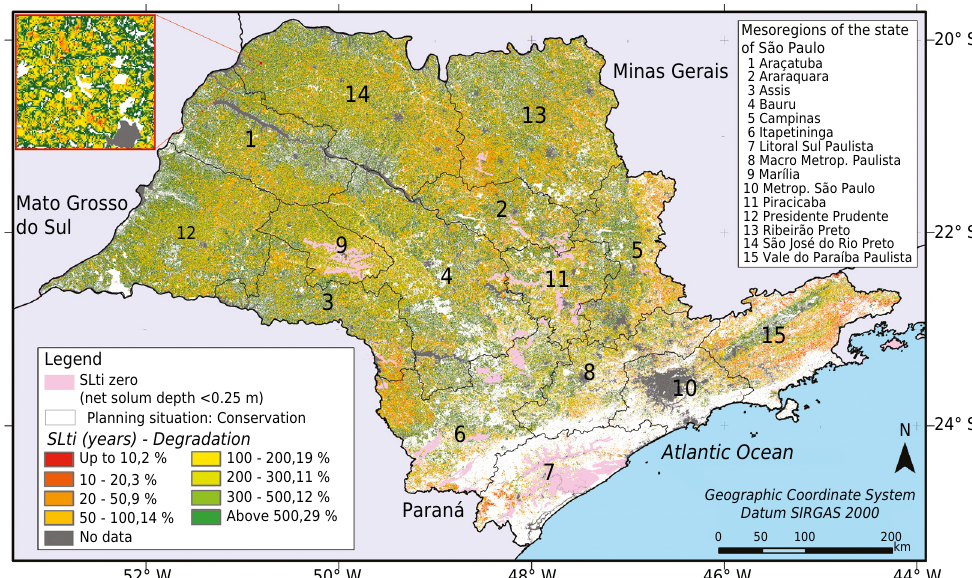
Figure 8. Soil Lifetime Index map of state of São Paulo (0.25